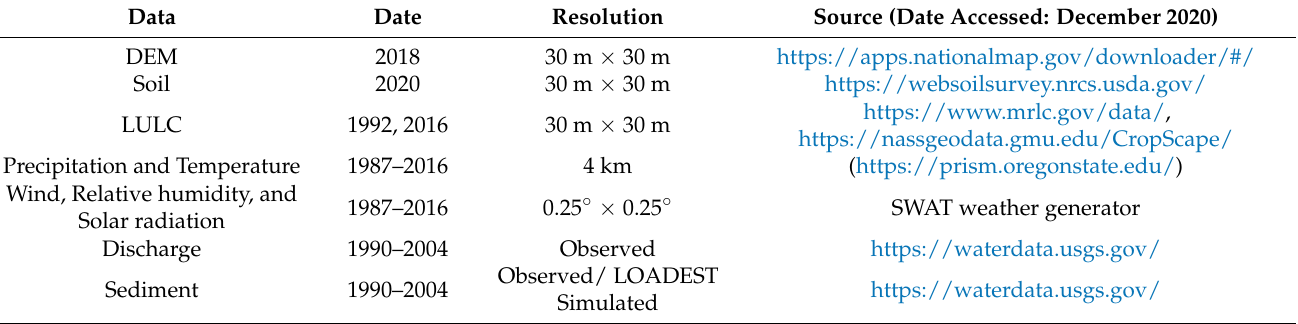
Table 1. Input data for the SWAT